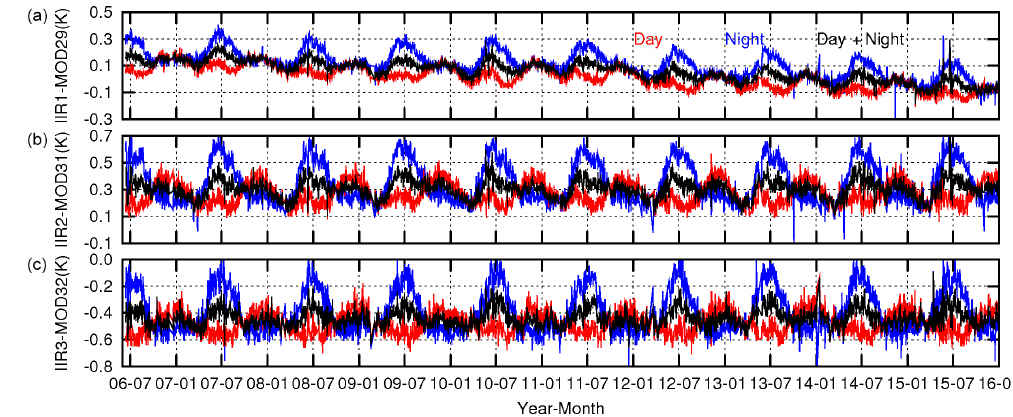
Figure 11. Time series ( x axis: year-month) of IIR–MODIS brightness temperature differences ( y -axis units: Kelvin) for the three pairs of companion channels ( a IIR1–MODIS29, b IIR2–MODIS31, c IIR3–MODIS32) over ocean at 30–60 ◦ N and 280–290K. Red: day only, blue: night only, black: day and